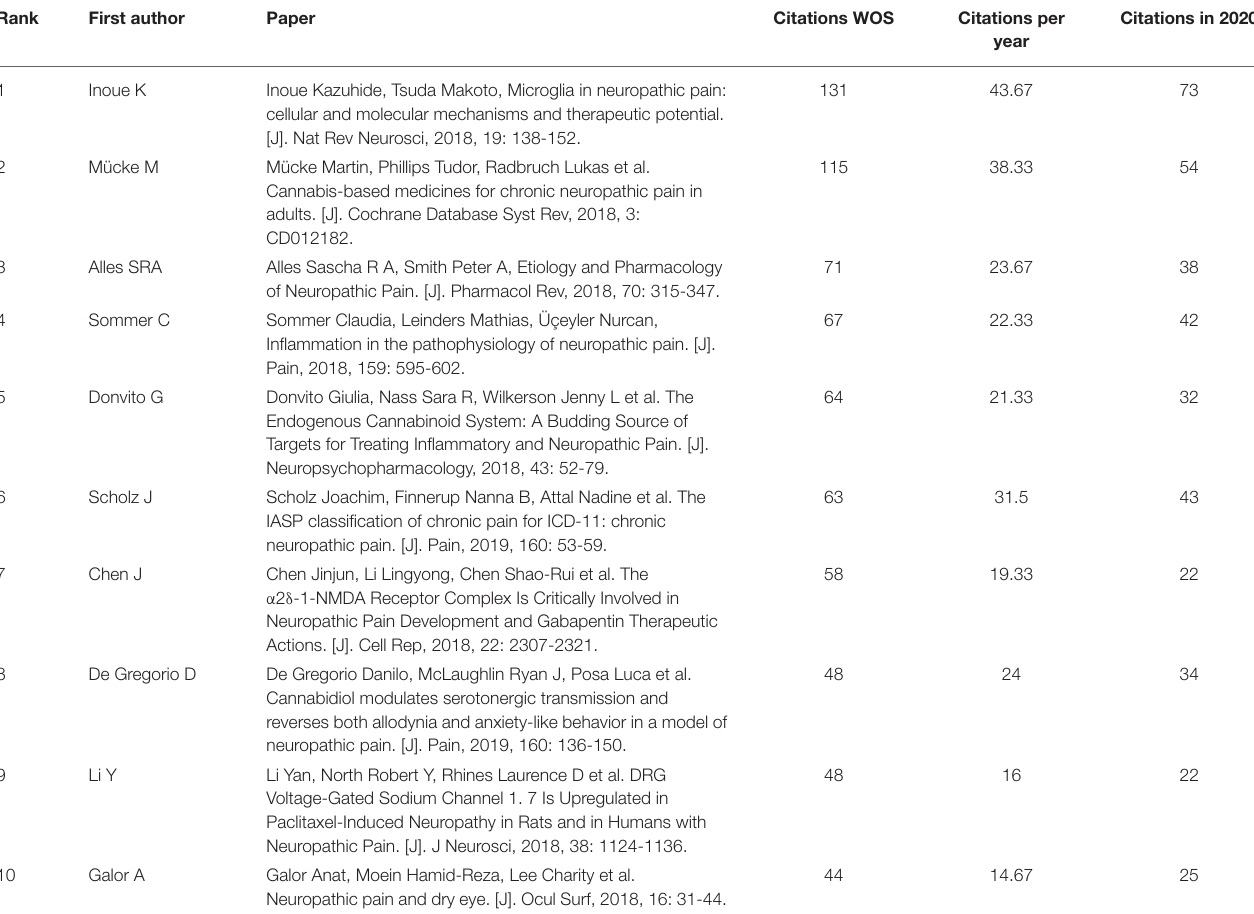
TABLE 5 | The top 10 most-cited papers on neuropathic pain from 2018 to